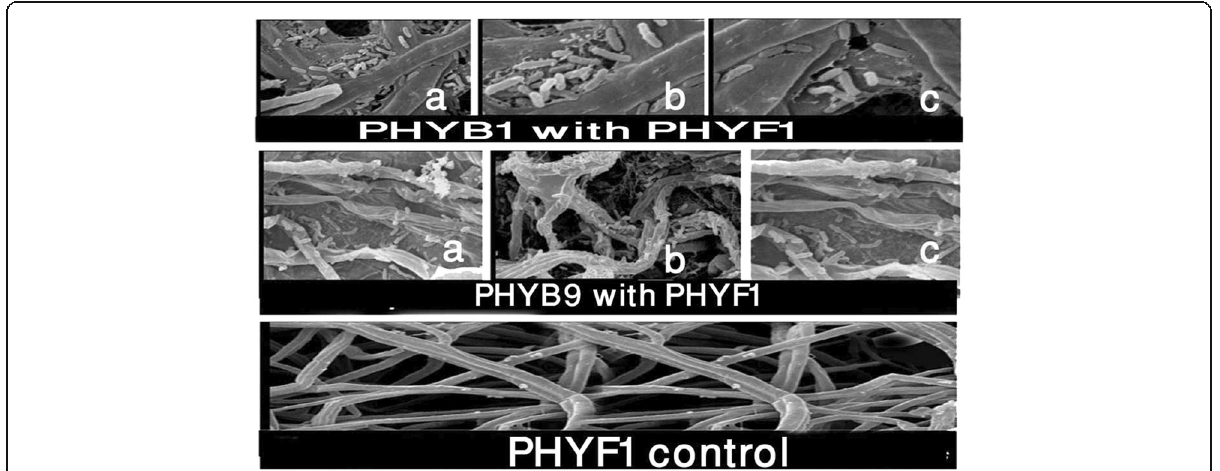
Fig. 2 Interaction between Bacillus simplex strain (PHYB1 and BHYB9 with mycelia of F. camptoceras (PHYF1). Electron microscopic scanning